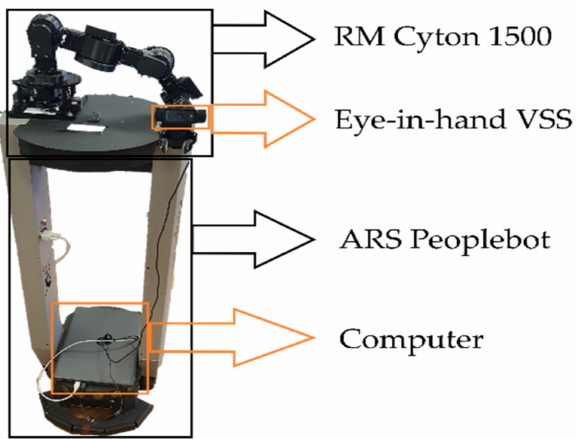
Figure 5. The CAS composed of ARS, RM, eye-in-hand VSS, and a